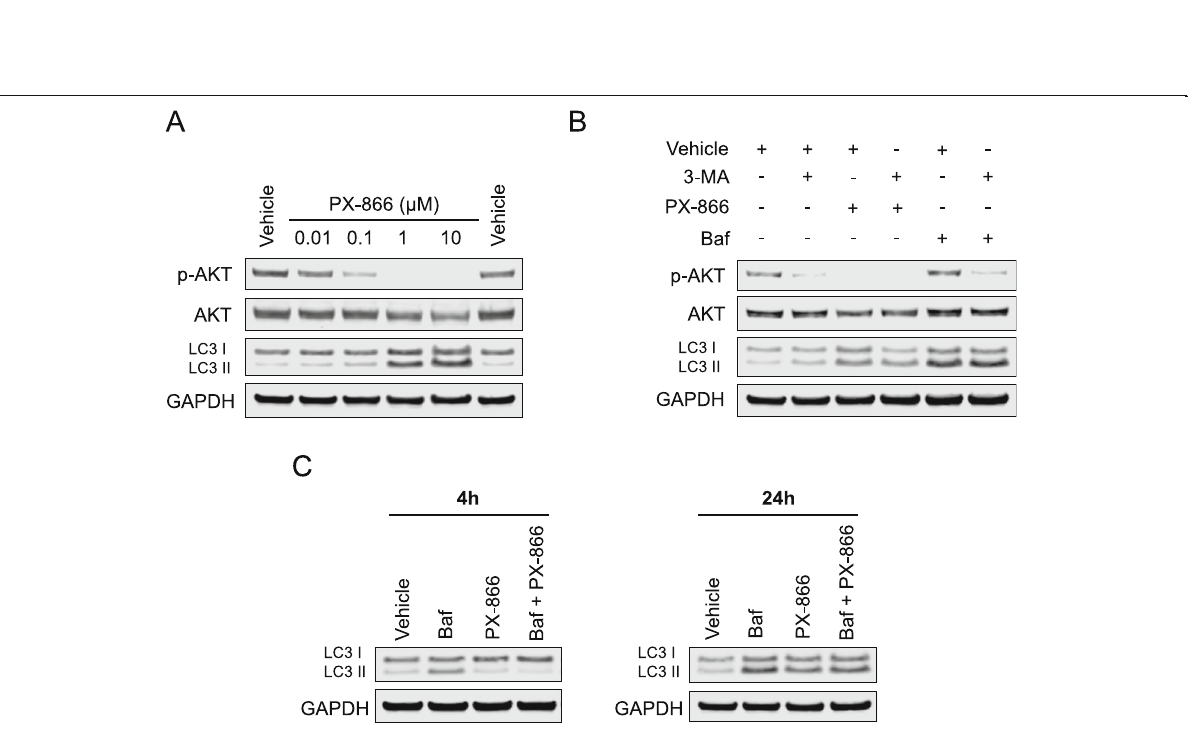
Fig. 4 PX-866 blocks autophagy in glioma cells. a T98G cells were treated with increasing doses of PX-866 for 24 h and then total protein was isolated. b T98G cells were subjected to single treatment with 3-MA (2.5 mM) or co-treatment with either PX-866 (1 μ M) or Baf (10 nM) for 24 h, according to the treatment legend. c The LC3 flux assay was performed on T98G cells at 4 h and 24 h using Baf (10 nM), PX-866 (1 μ M) or a combination of the two. Data represents three independent